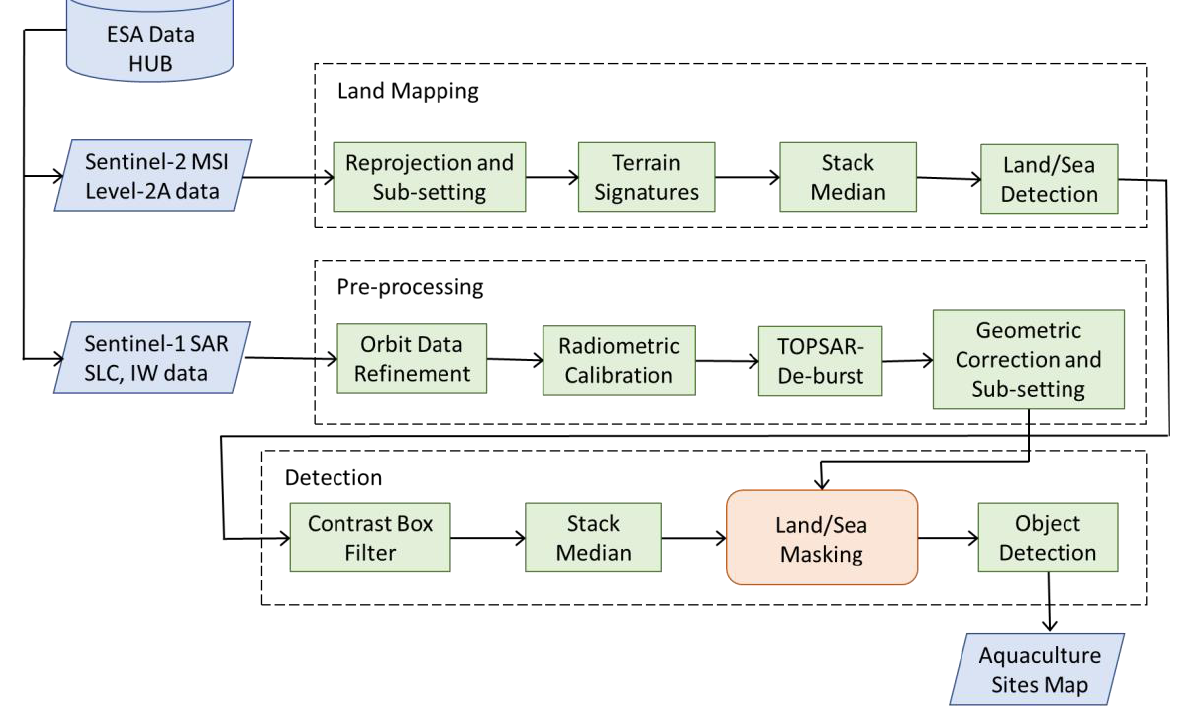
Figure 3. The EO data processing and aquaculture maps generation chain. It has two parallel branches for the Sentinel-1 SAR and Sentinel-2 MSI data processing and a branch for aquaculture object detection.